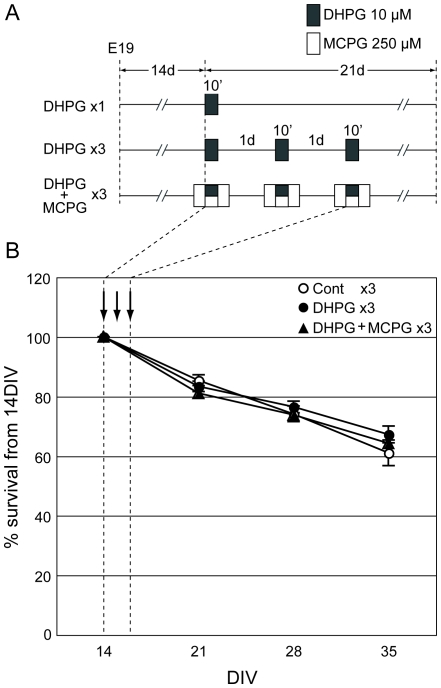
Drug application and cell viability.(A) Cultured neurons at 14 DIV were treated with DHPG (filled boxes, 10 µM, 10 min) with or without MCPG (open boxes, 250 µM, 30 min). Drugs were applied once a day, either singly or three times. MCPG was applied from 10 min prior to 10 min after DHPG exposure. (B) The survival rate during the experimental period. Arrows indicate the days of drug application. The number of surviving cells was slightly decreased after repetitive control (open circle), DHPG (filled circle), and DHPG with MCPG (filled triangle) treatment, although there was no significant difference between the groups. The numbers of cultures for each plot were 11 (control), 12 (DHPG), and 6 (DHPG+MCPG), respectively. Error bars indicate SEM.